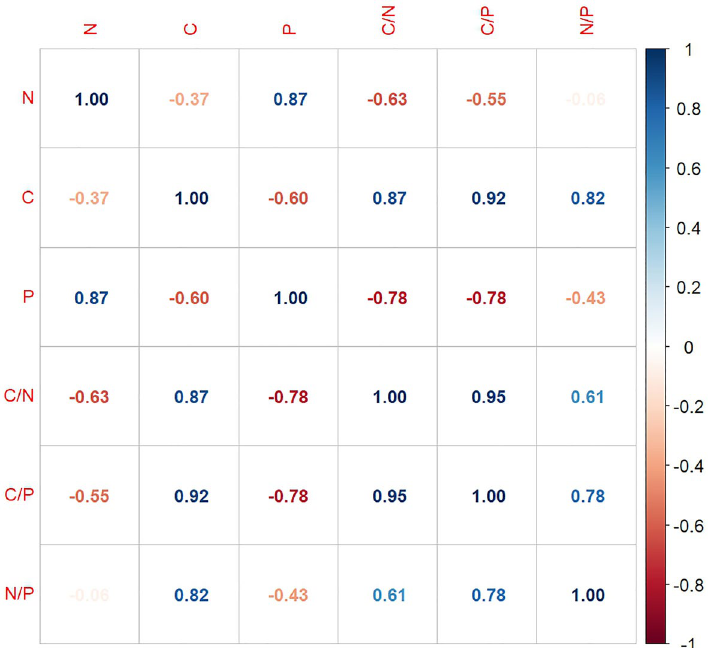
Figure 3. Correlation between content of N, C and P and stoichiometry C/N/P in wood and soil samples.